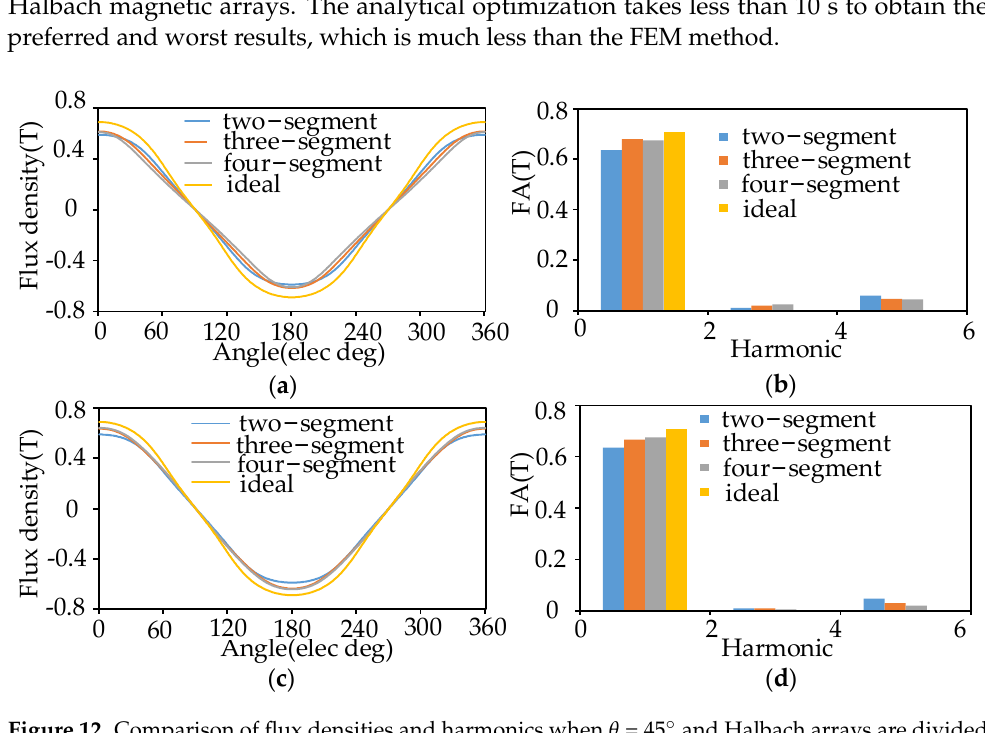
Figure 12. Comparison of flux densities and harmonics when θ = 45° and Halbach arrays are divided into equal parts in ( a , b ) and optimal θ and α r in ( c , d ).